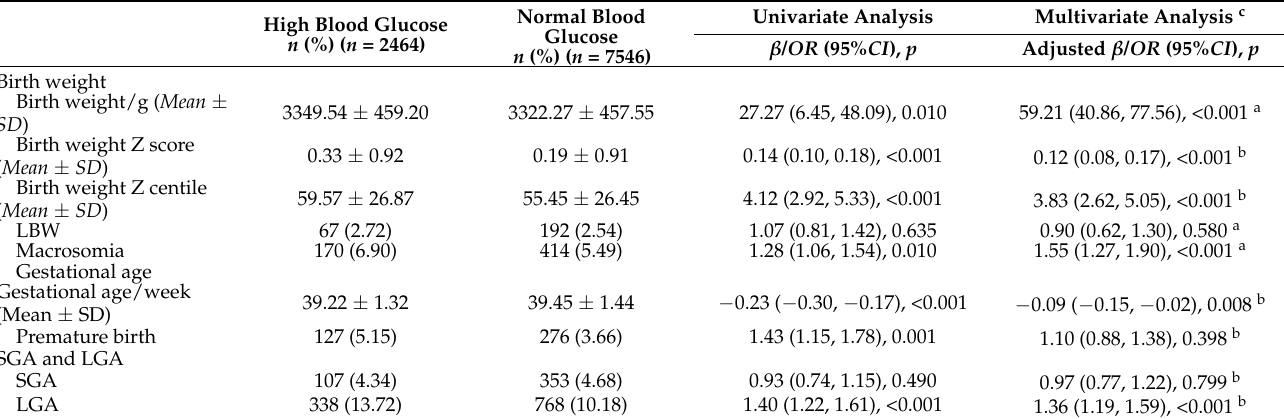
Table 2. Association of high blood glucose and birth outcomes ( n =